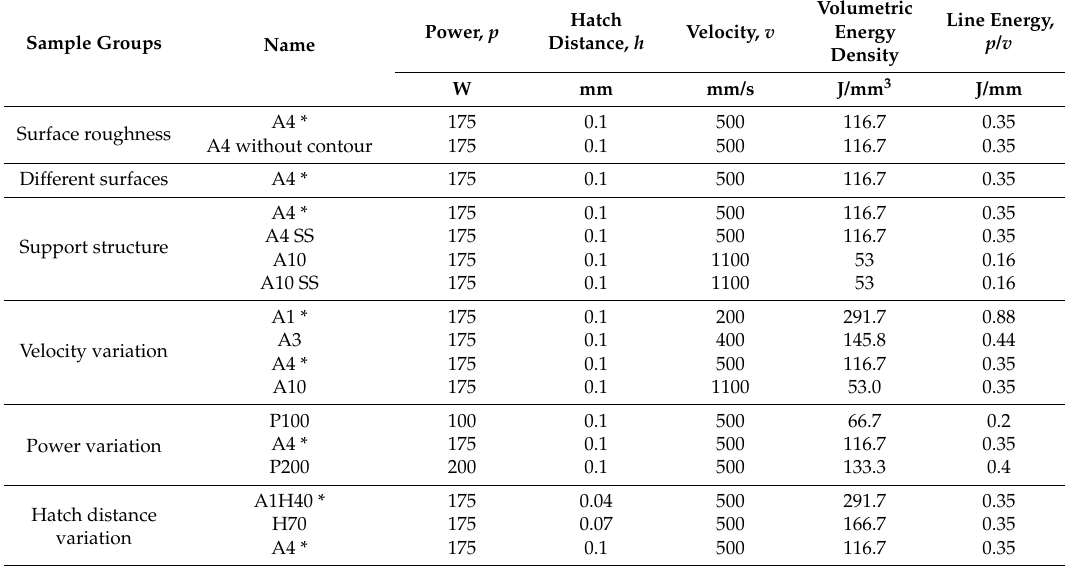
Table 1. Processing parameters.